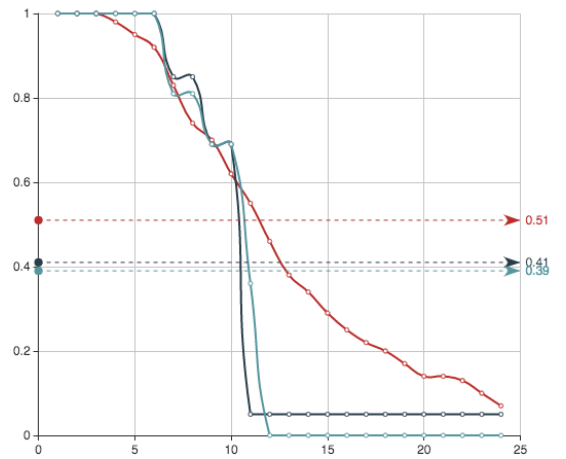
Figure 7. Representation of the survival function estimates for the three methods. The red line is the crude Monte Carlo estimate (big Error 422.7197), the black one is the genetic algorithm result, and the red one is the exact approximation based on the Karush-Kuhn-Tucker conditions. The errors for this last/better method are 89.7183—when the constraint sum = 1 is assumed, and 131.0098 for the case sum <